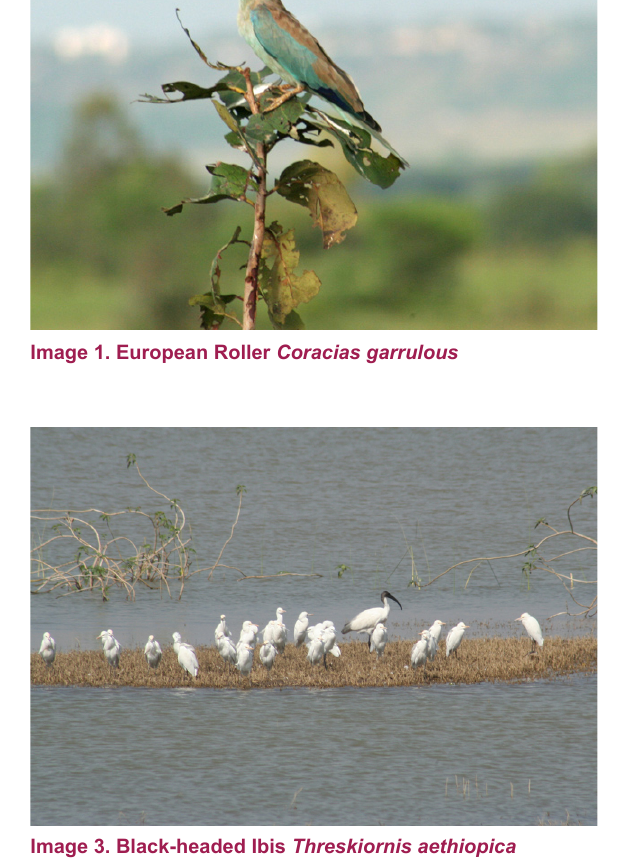
Table 3. Observation of the threatened birds of Osmanabad District